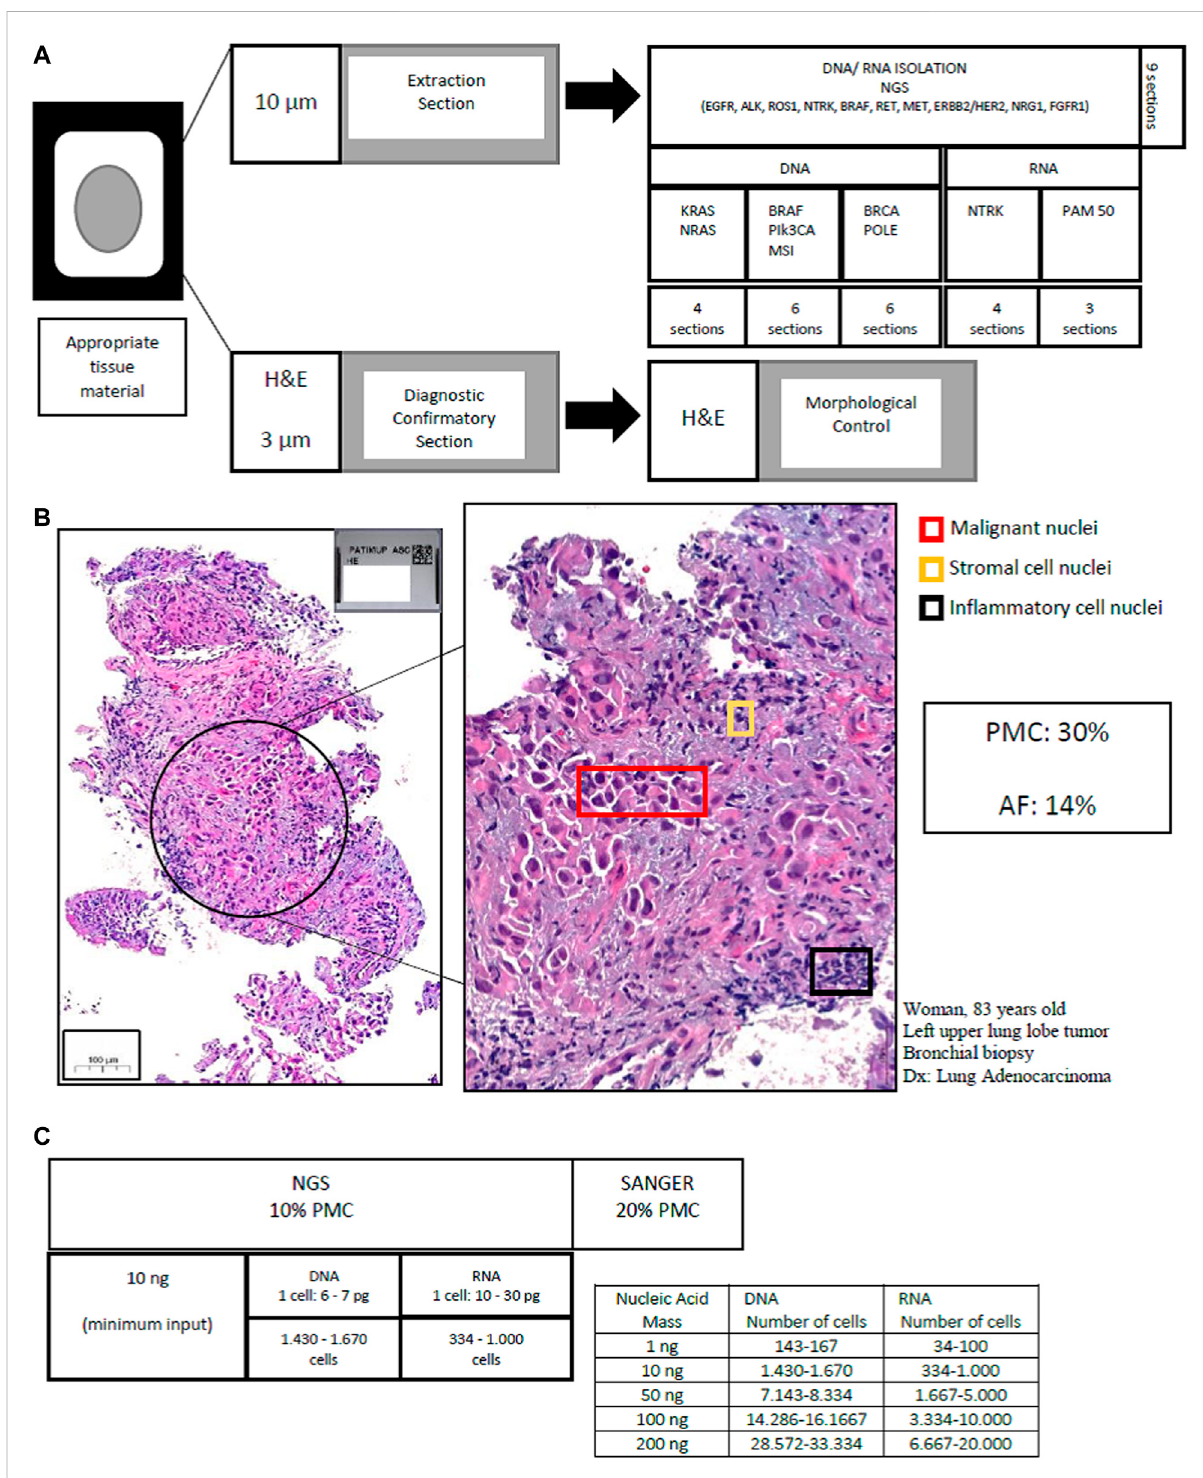
FIGURE 1 Work fl ow to sample processing and morphological control in molecular pathology. (A) Tissue cutting protocol (FFPE or cytological preparations):DNA/RNAextractionandH&Estainformorphologicalcontrol. (B) MorphologicalControlinlungadenocarcinoma:Thepercentageof neoplastic cells corresponds to the percentage of malignant nuclei. Pathological assessment that 30% of the malignant cells were viable. The allele frequency veri fi ed was 14%, con fi rming the estimate. (C) Number of cells needed by nucleic acid quanti fi cation in single-multi-gene assays. PMC (percentage malignant cell), AF (allele frequency), NGS (next generation